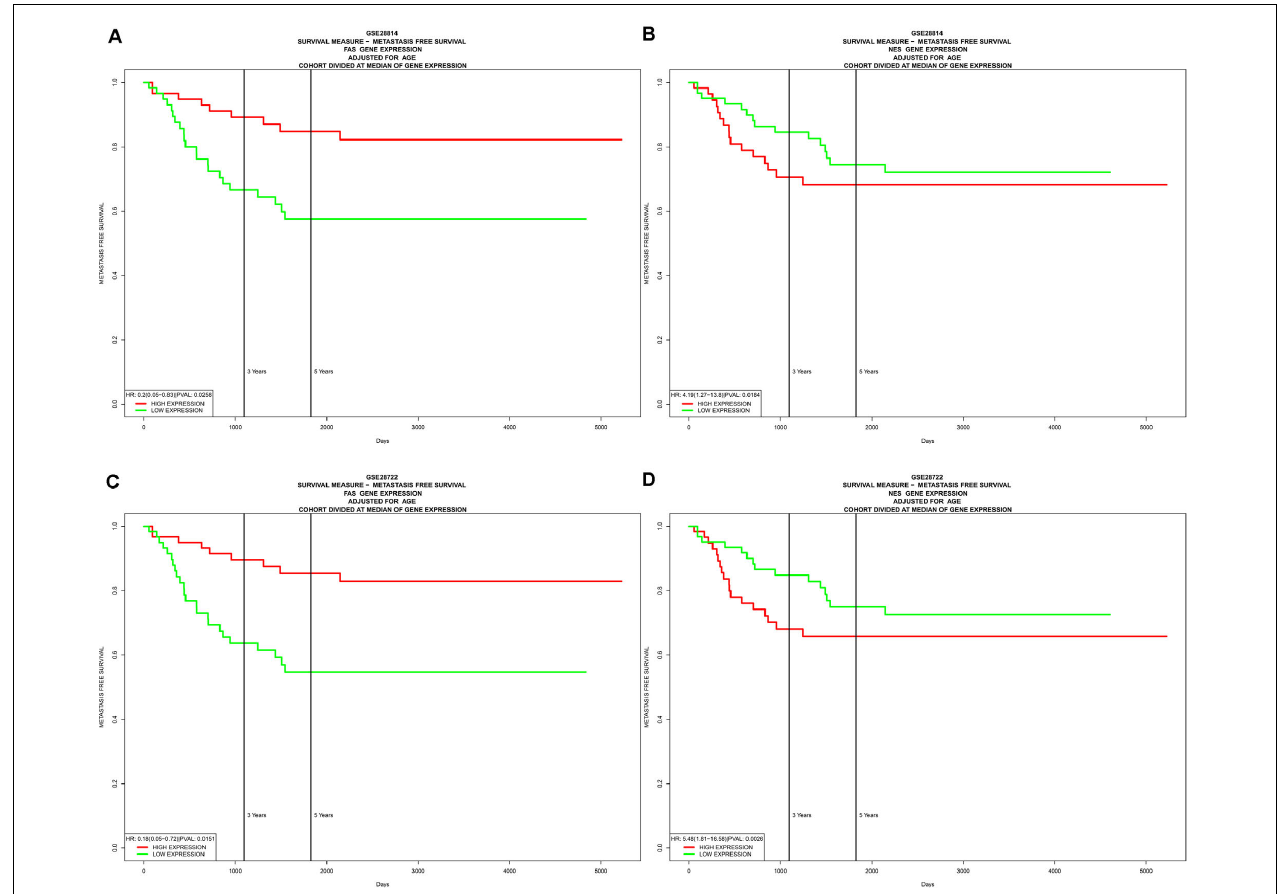
FIGURE 11 | Independent data sets validation of metastasis-free survival (MFS) by GSE28814 and GSE28722. In the two independent data sets, both FAS (GSE28814: P = 0.026; GSE28722: P = 0.015) (A,C) and NES (GSE28814: P = 0.018; GSE28722: P = 0.003) (B,D) had significant metastasis-free survival (MFS) with